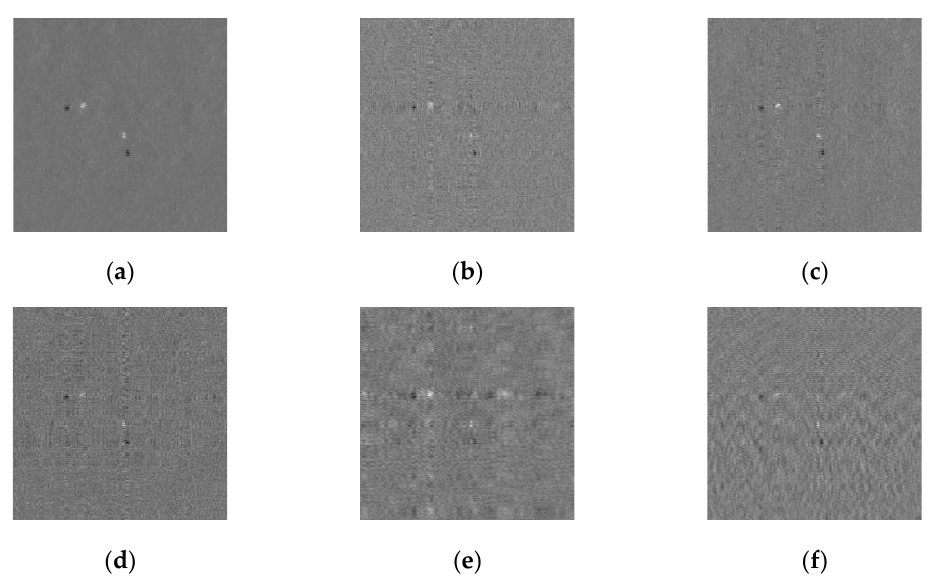
Figure 4. Subtraction image mapping by different measurement matrixes: The targets in the space domain mapping images are more prominent compared with the original image. ( a ) Real spatial subtraction image, ( b ) Space domain mapping image by Gauss, ( c ) Space domain mapping image by Part Hadamard, ( d ) Space domain mapping image by Bernouli, ( e ) Space domain mapping image by Circulant, ( f ) Space domain mapping image by Toeplitz.